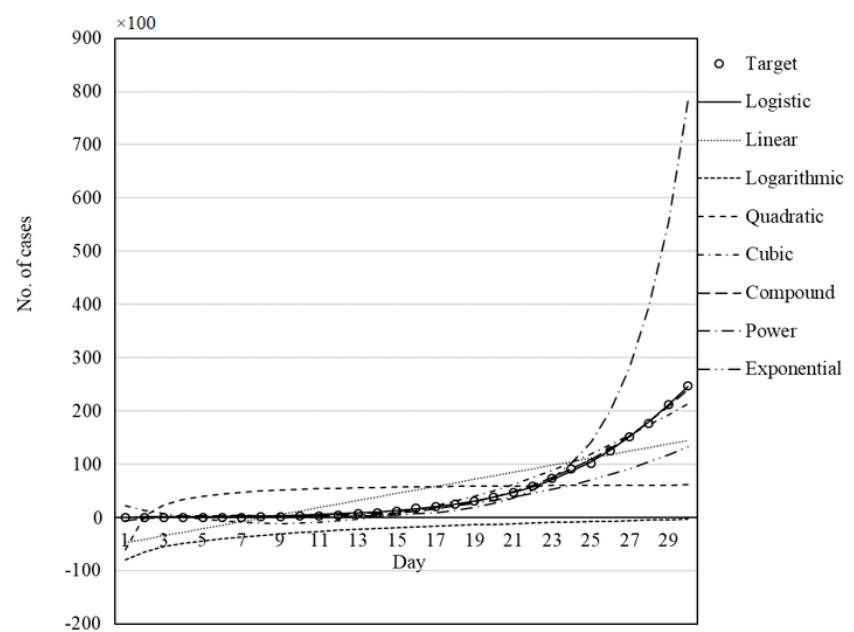
Figure 8. Set of models for Italy fitted by GWO.